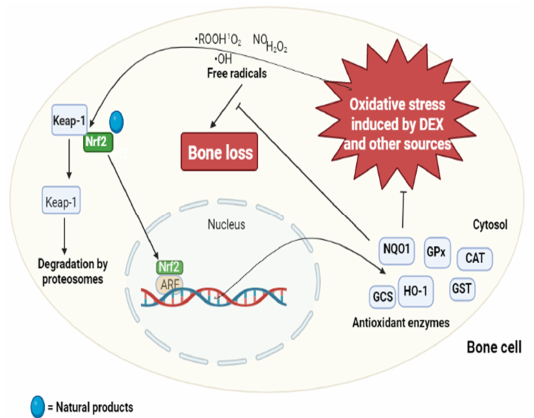
Figure 3. Modulation of bone remodeling by natural products via Keap-1/Nrf2 signaling pathway. Bone loss caused by oxidative stress due to an imbalance in the antioxidant and free radicals in the system can be alleviated by natural products with antioxidant ability. Natural products promote the